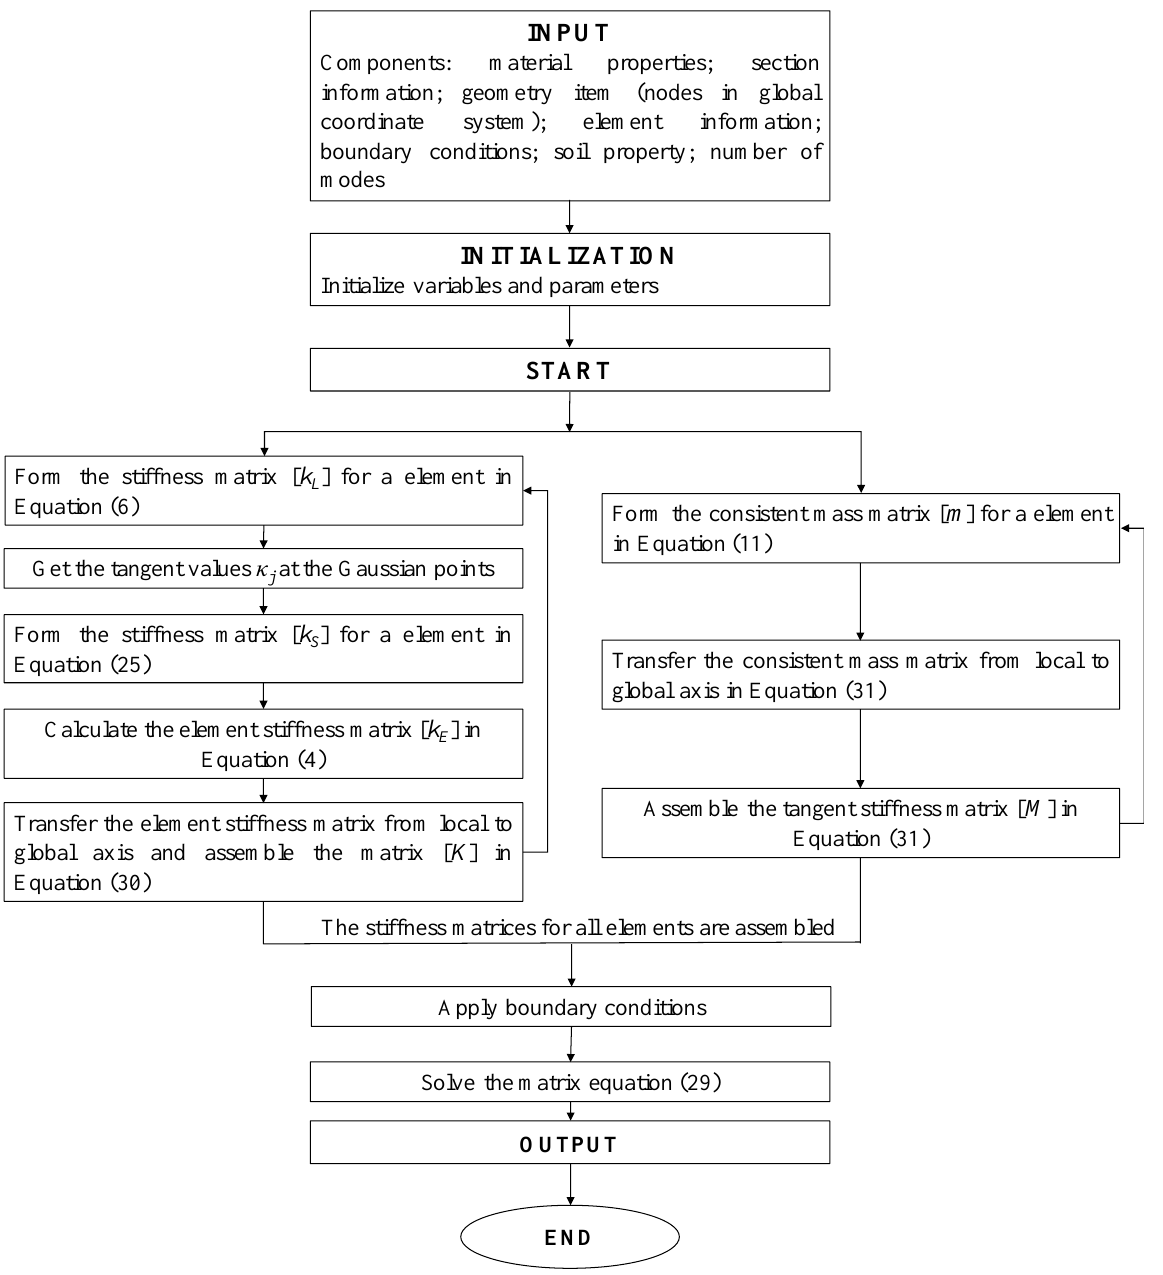
Figure 5. Flow chart of the numerical analysis procedure.